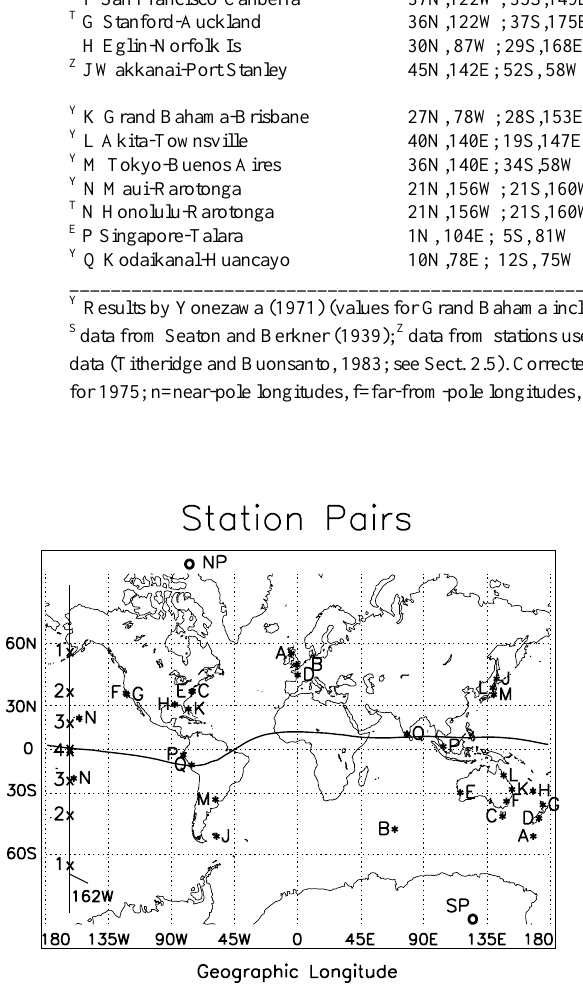
Geographic Lat, Long.